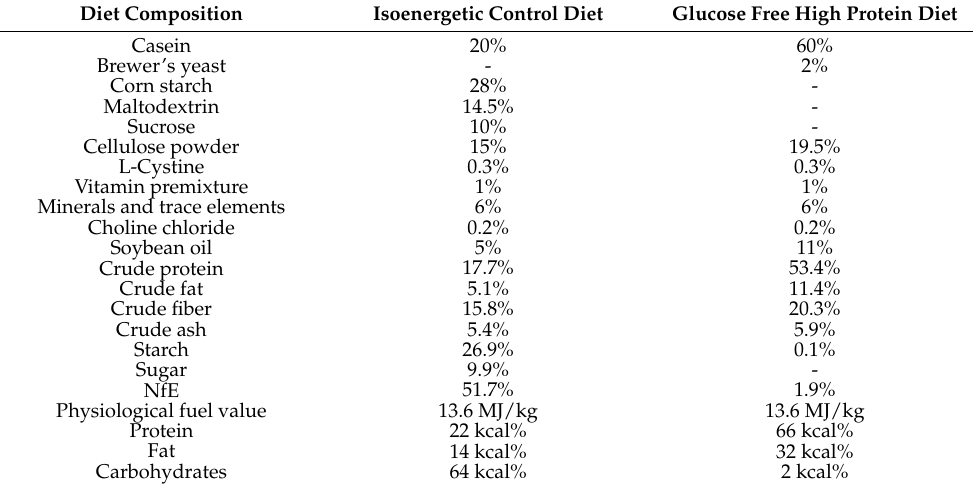
Table 1. Chow composition as provided by the manufacturer. Diet Composition Isoenergetic Control